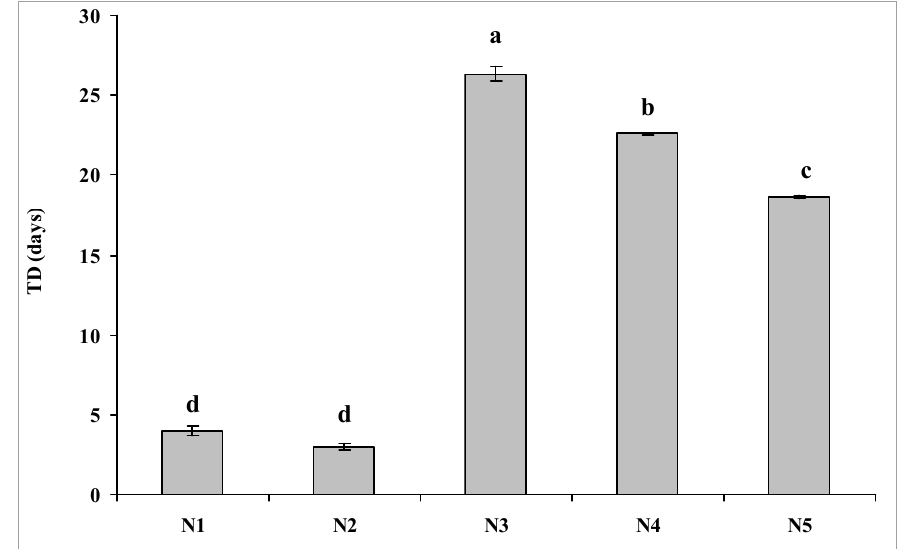
Figure 4. The survival time needed to reach the detection limit ( t d , in days) for E. coli O157:H7 in the test soils. Bars are mean ± 1 standard deviation. Different letters on the error bars indicate significant differences at p < 0.05.